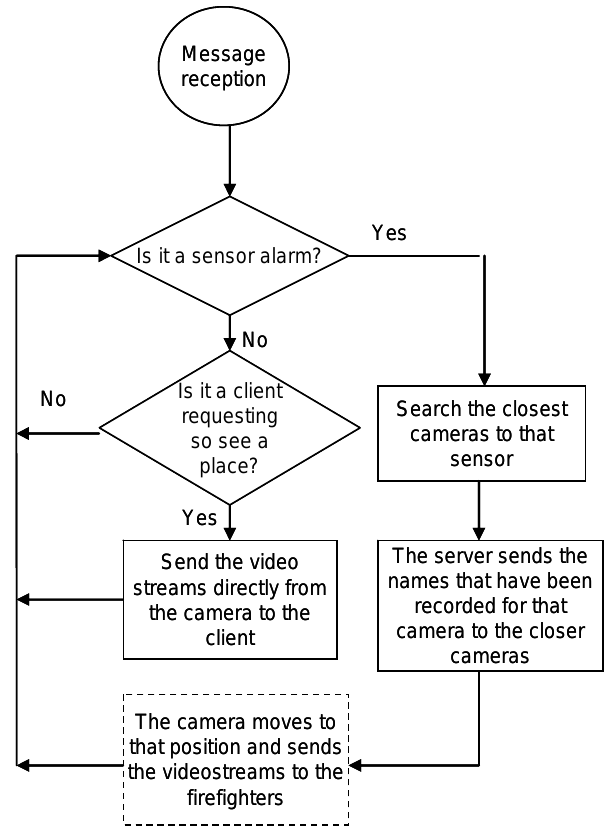
Figure 8. System Mode Operation Flowchart.